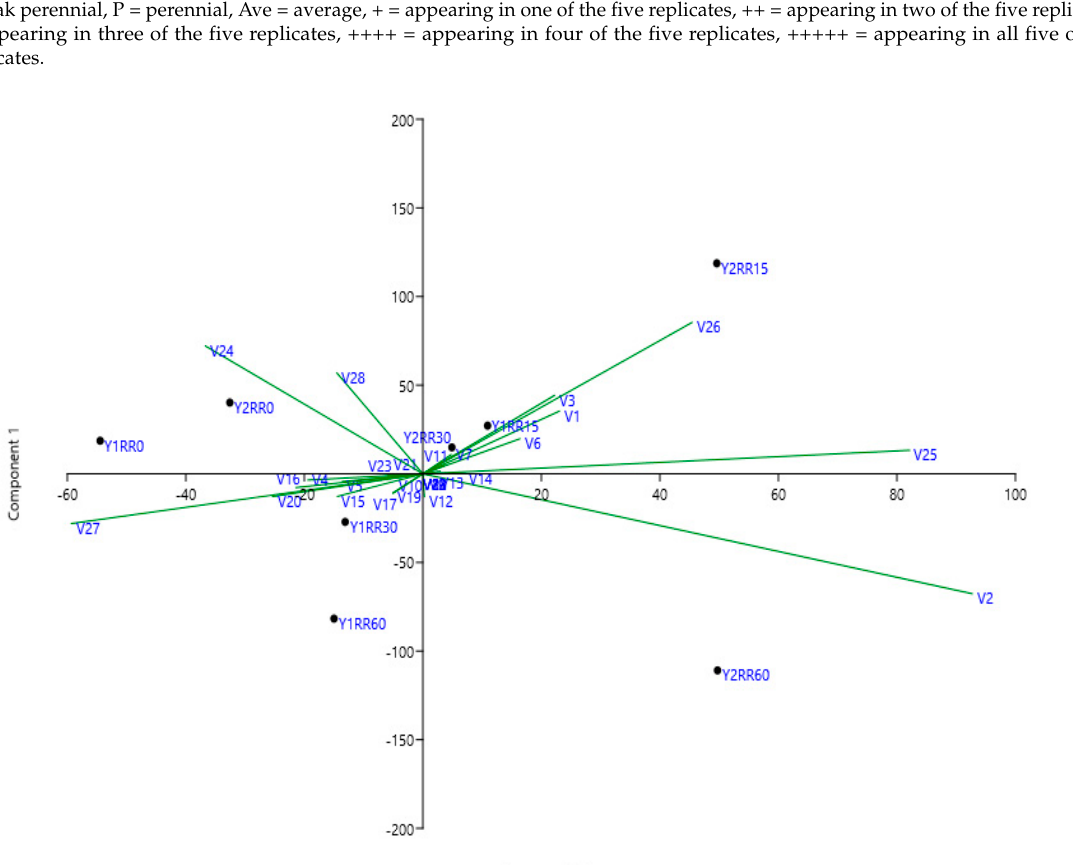
Figure 4. Grass and forb species densities per square meter over a period of two years (2017 and 2018): V1 = Eragrostis curvula, V2 = Cynodon dactylon , V3 = Digitaria eriantha , V4 = Setaria nigrirostris , V5 = Themeda triandra, V6 = Heteropogon contortus , V7 = Setaria sphacelata, V8 = Eragrostis barbinodis, V9 = Melinis repens , V10 = Brachiaria serrata , V11 = Aristida congesta , V12 = Ipomoea crassipes, V13 = Elephantorrhiza elephantina, V14 = Rhynchosia monophylla , V15 = Bryophyllum delagoense , V16 = Hypoxis hemorocallida , V17 = Nidorella resedifolia , V18 = Conyza fleabane, V19 = Verbena officinalis , V20 = Bidens pilosa , V21 = Cyperus species, V22 = Urochloa mosambicensis ,V23 = Solanum species, V24 = decreasers, V25 = increasers, V26 = forbs, V27 = total density, Y1RR0 and Y2RR0 = 0% RR in 2017 and 2018, respectively, Y1RR15 and Y2RR15 = 15% RR in 2017 and 2018, respectively, Y1RR30 and Y2RR30 = 30% RR in 2017 and 2018, respectively, Y1RR60 and Y2RR60 = 60% RR in 2017 and 2018, respectively.